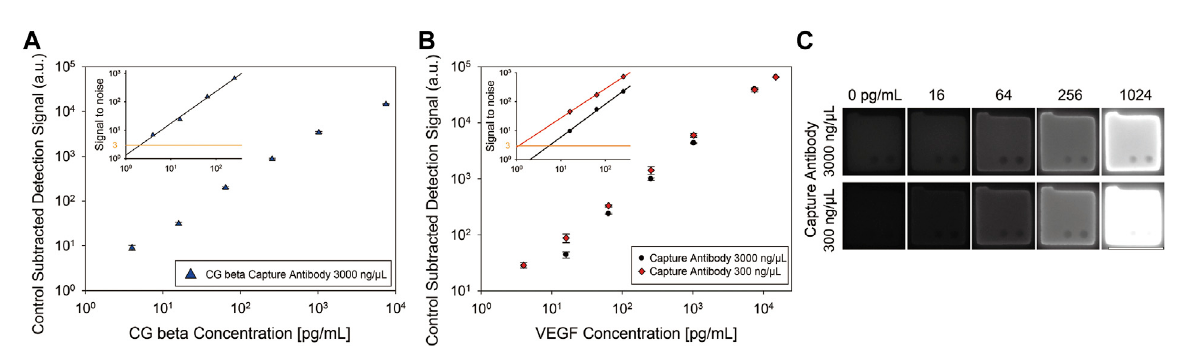
FIGURE 3 Singleplex assay results of CG beta and VEGF. (A) Control-subtracted CG beta detection signals using particles incubated with 3,000 ng/ μ l of capture antibody. (B) Control-subtracted VEGF detection signals using two types of particles, each incubated with 3,000 ng/ μ l and 300 ng/ μ l of capture antibody. The inset displays signal-to-noise, signals divided by standard deviation of the control for each case. LOD is the target concentration where each regression plot intersects with y = 3. (C) Fluorescence images of the hydrogel microparticles from VEGF singleplex detection. The scale bar is 100 μ m.